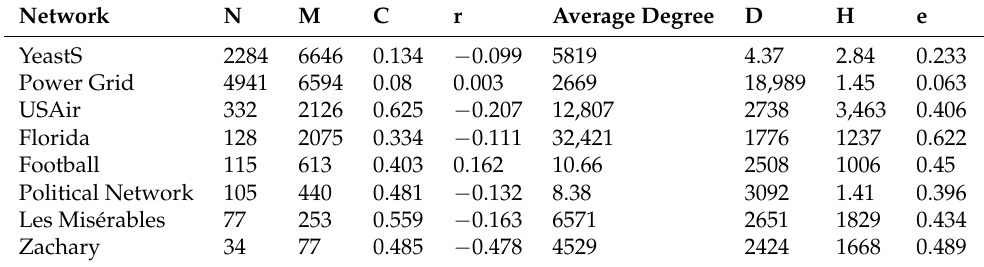
Table 2. Network